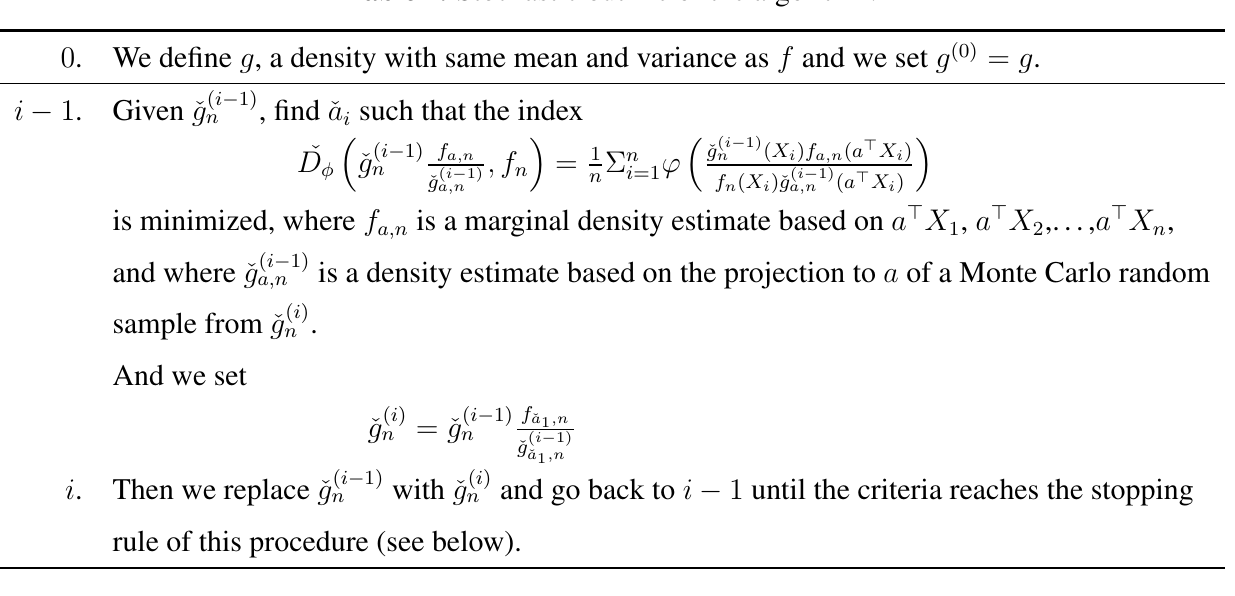
Table 2. Stochastic outline of the